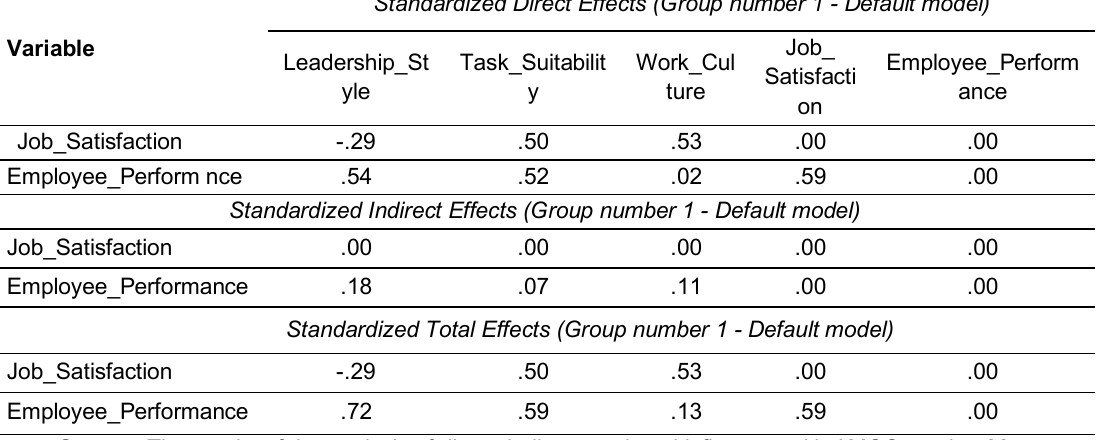
Tabel 2: The Results of The Analysis of Direct, Indirect, and Total